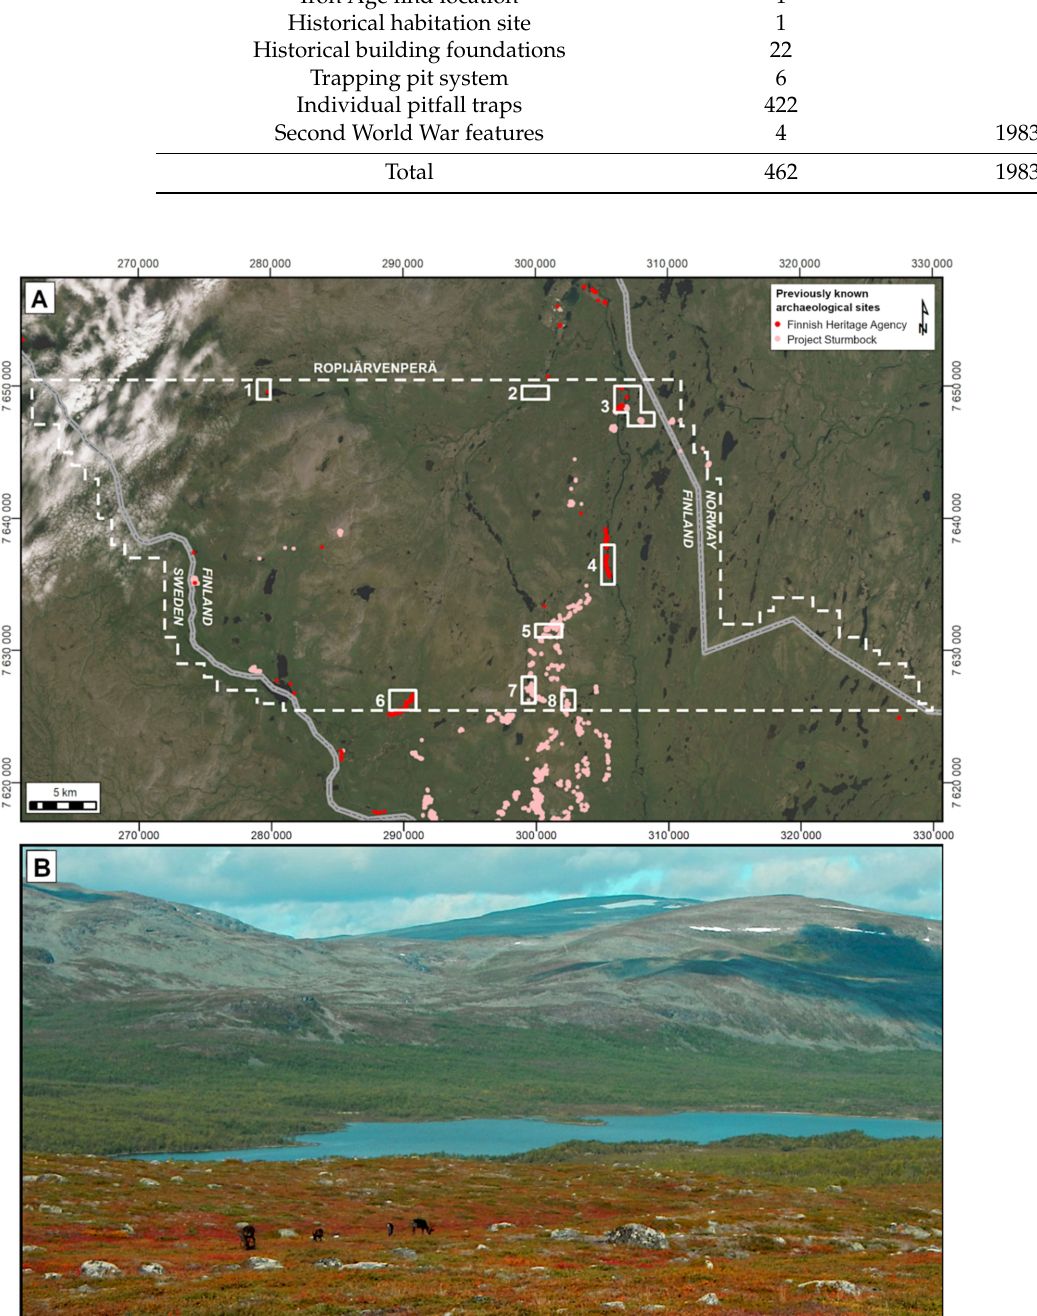
Figure 2. ( A ) Ropijärvenperä production area, case study areas 1–8, and the previously known archaeological features in the area (Finnish Heritage Agency: red, N = 462; Project Sturmbock: pink, N = 1983). (Background © Esri, Maxar, GeoEye, Earthstar Geographics, CNES/Airbus DS, USDA, USGS, AeroGRID, IGN, and the GIS User Community; EPSG:3879 ETRS89/GK25FIN). ( B ) Typical landscape in the area, with open Alpine tundra up on the fjelds and mountain birch brush covering the valleys, notice the grazing reindeer on the foreground. (Illustration and photograph: Oula